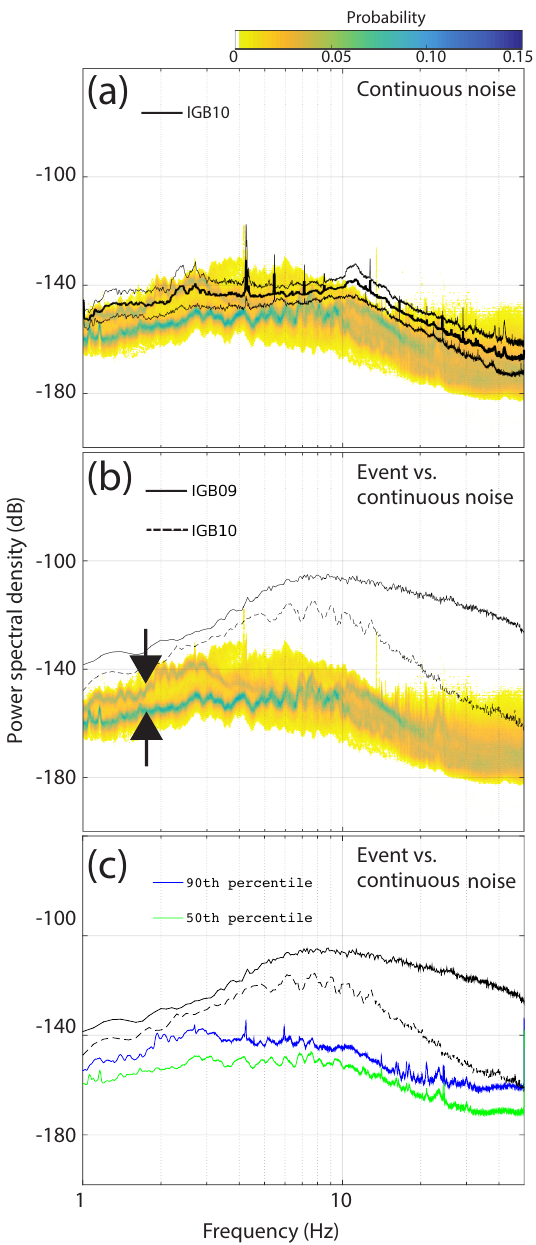
Figure 13. Debris-flow spectra recorded at IGB09 and IGB10 to- gether with probabilistic spectral representation of a noise time win- dow recorded between 27 May and 16 July 2015 at station IGN01 (“PSD-PDF”). (a) Comparison between noise PSD-PDFs at IGN01 and noise mean and standard deviation at IGB10 for the day of the debris flow (thick and thin black lines, respectively). (b) Noise PSD-PDF of station IGN01 and debris-flow spectra of IGB09 and IGB10. Black arrows point to the two PDF branches discussed in the main text. (c) Debris-flow spectra at IGB09 and IGB10 with 50th and 90th percentile of noise PSD-PDF of IGN01. Note that at both stations (IGB09 and IGB10), the debris-flow signal domi- nates the seismic noise measured at IGN01 over the entire shown frequency range